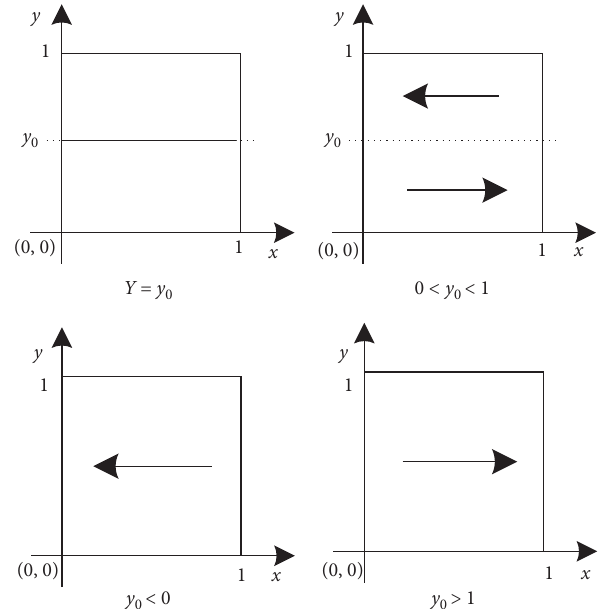
Figure 1: Government replication dynamic phase